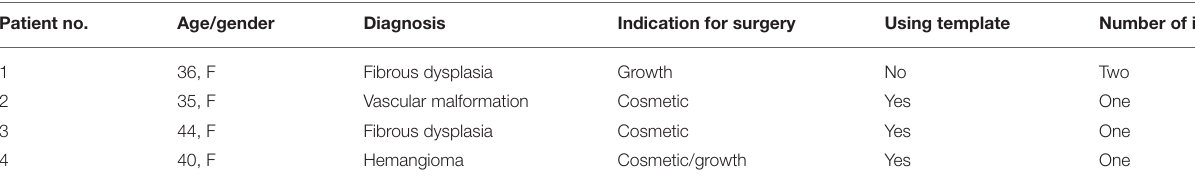
TABLE 1 | Patient profiles, surgery, and results. Patient